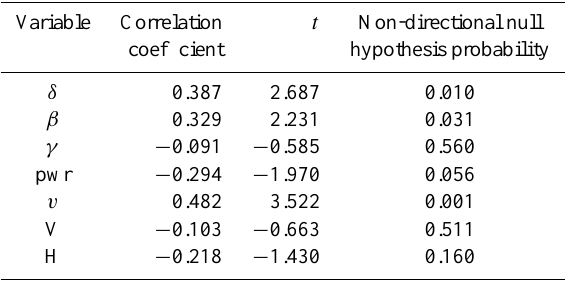
Table 2. Statistical correlations between ρ and other observables, Student’s t-values and non-directional null hypothesis probabilities. All events included.